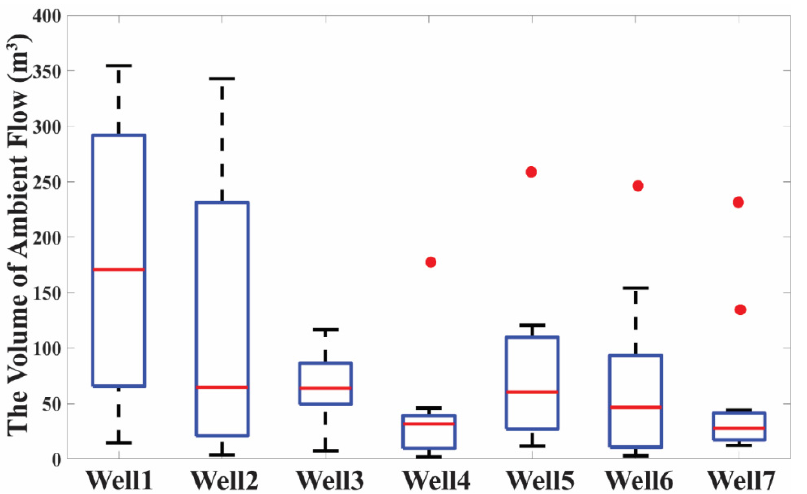
Figure 7. The estimated volume of ambient flow ( V AF ) in 7 wells. Red point represents the outlier values of calculated ambient flow volume, which is larger than 1.5 times the interquartile range above the third quartile.